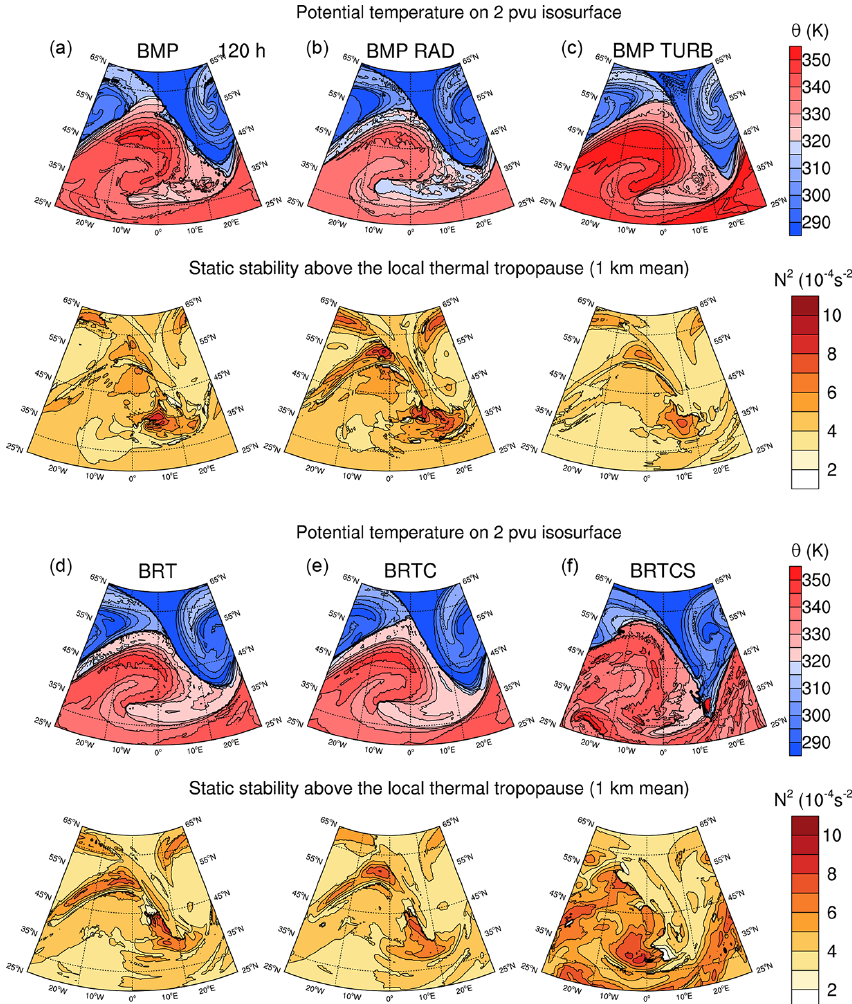
Figure 8. Dynamical and thermodynamical state of baroclinic life cycles after 120h of model integration. In the upper rows of the six panels, the distribution of potential temperature (cid:50) (in K) on the dynamical tropopause is depicted, while the lower rows show the distribution of static stability N 2 (in 10 − 4 s − 2 ) averaged over the first kilometer above the thermal tropopause for (a) BMP, (b) BMP RAD, (c) BMP TURB, (d) BRT, (e) BRTC, and (f)